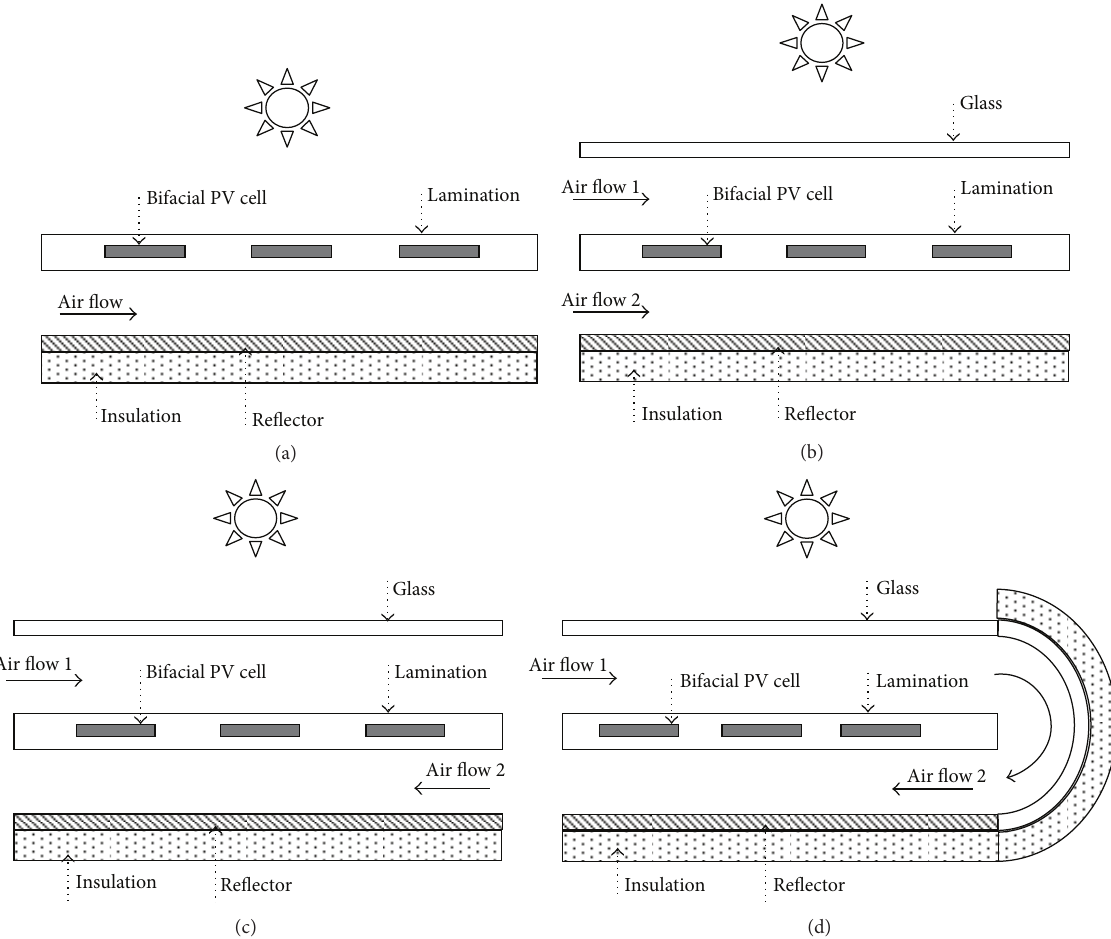
Figure 2: Cross-section view of bifacial PVT panel: (a) Model 1; (b) Model 2; (c) Model 3; and (d) Model